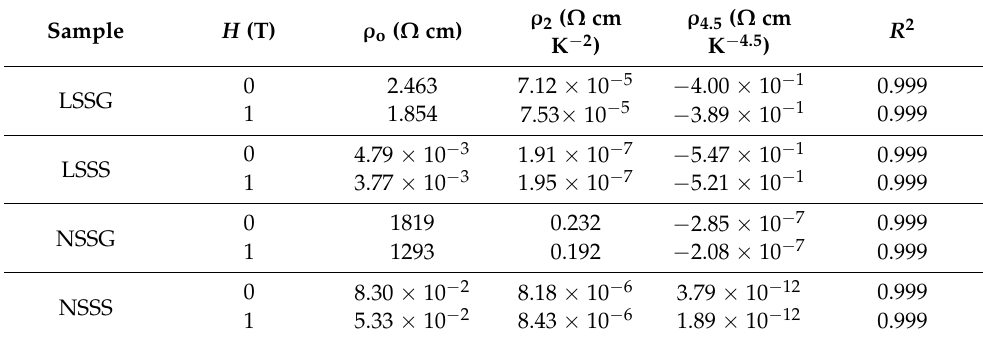
Table 3. Parameters obtained corresponding to the best fit of the experimental data based on Equation (3) from LSMO and NSMO